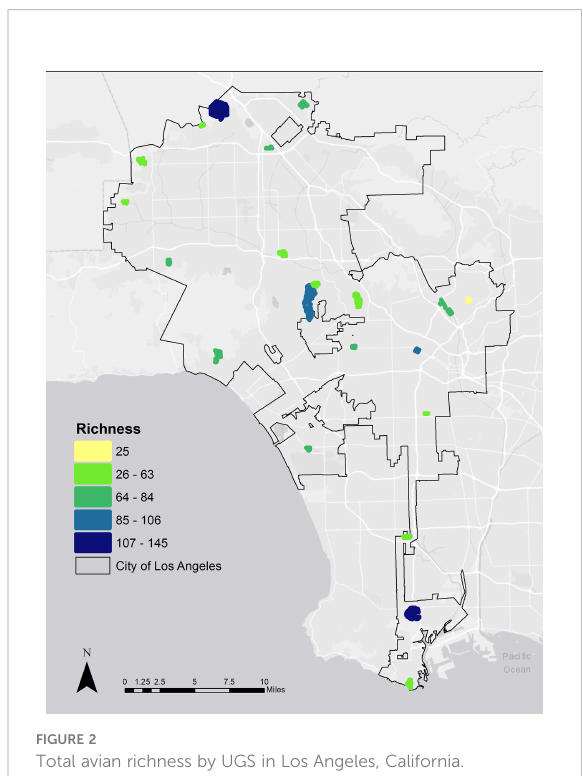
FIGURE 2 Total avian richness by UGS in Los Angeles,